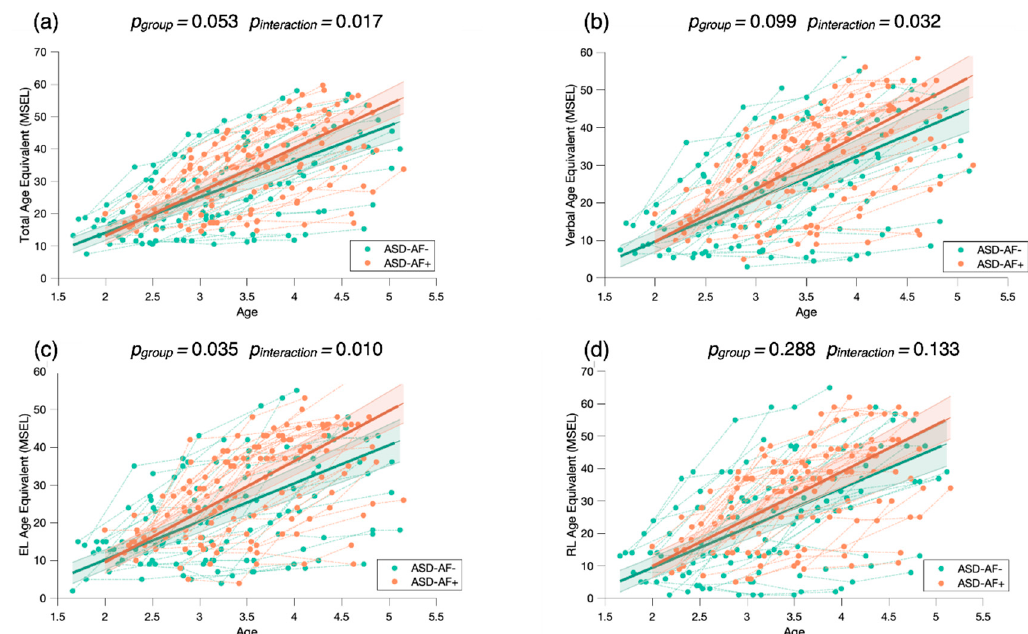
Figure 5. Mixed model regression analysis of the MSEL Total Age Equivalent ( a ), Verbal Age Equivalent ( b ), Expressive Language Age Equivalent ( c ), and Receptive Language Age Equivalent ( d ) for 265 longitudinal recordings from 81 young children with ASD (2.78 ± 0.65 years old) who demonstrated a lower ( ASD-AF- ) or higher ( ASD-AF+ ) attention to face (AF) at baseline. The group-level trajectory (bold line) is derived from mixed-effect modeling [43–45]. The 95% confidence interval is indicated by the colored bands around the estimated group-level trajectory.